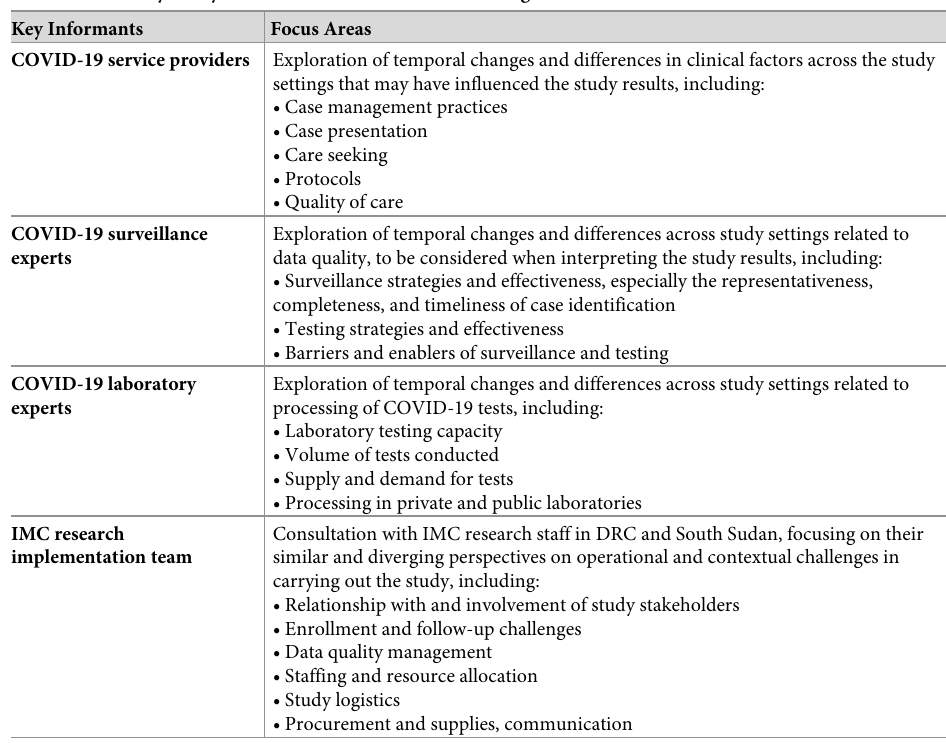
Table 2. Summary of key informants and areas of focus during interviews. Key